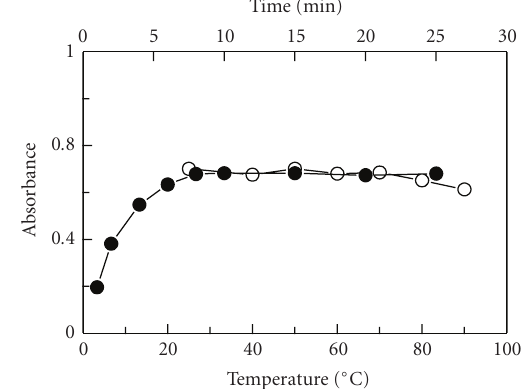
time up to 25 minutes did not a ff ect the reaction (Figure 5).